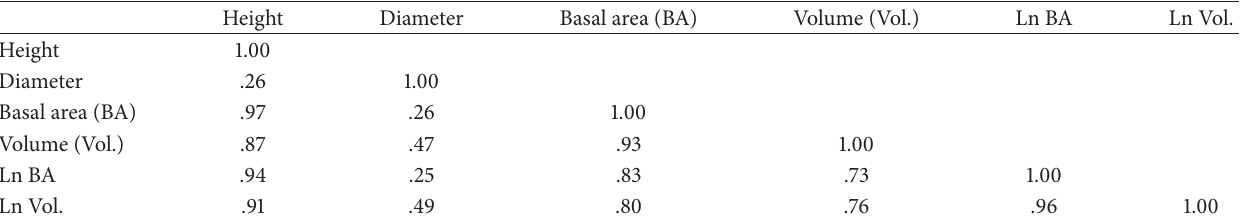
Table 6: Correlation coefficients for tree growth variables in urban area (FCT,